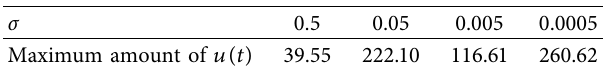
Figure 8: Variation of the control parameter of u ( t ) for Figure 7. (a). σ � 0 . 5, (b). σ � 0 . 05, (c). σ � 0 . 005, and (d). σ � 0 . 0005. Table 3: Maximum amount of control force u ( t ) for various amount of σ